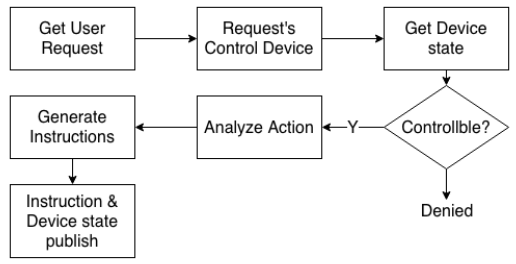
Figure 4. The flowchart of the analysis of user request.